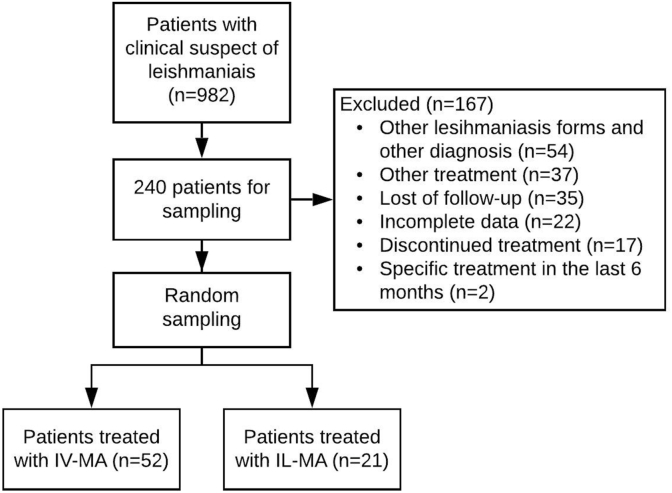
Flowchart of patient selection. Legend: IV-MA = Intravenous meglumine antimoniate; IL-MA: Intralesional meglumine antimoniate.